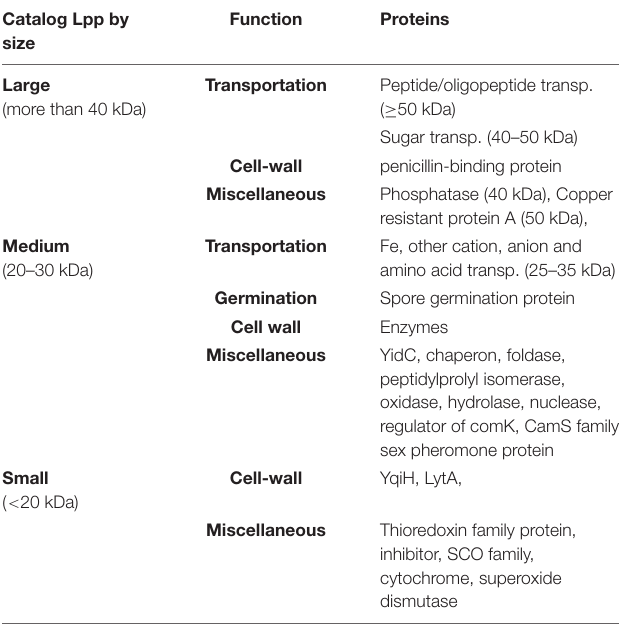
TABLE 3 | The correlation between the function and the size of Lpp. Catalog Lpp by size